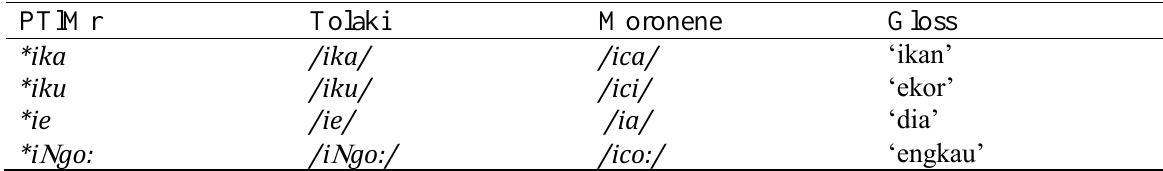
Table 4. The initial position of the